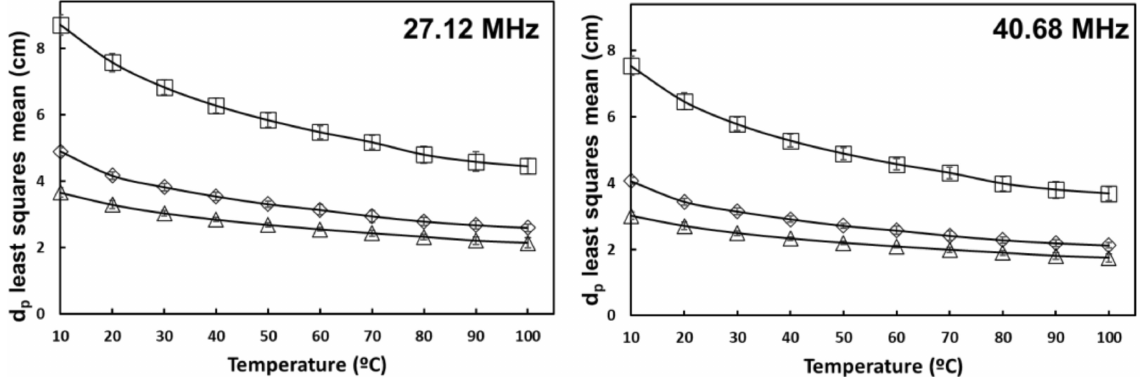
Figure 8. Temperature and salt interaction effect on the penetration depth of tomato homogenate at 27.12 and 40.68 MHz. ) 1% salt. Error bars correspond to standard